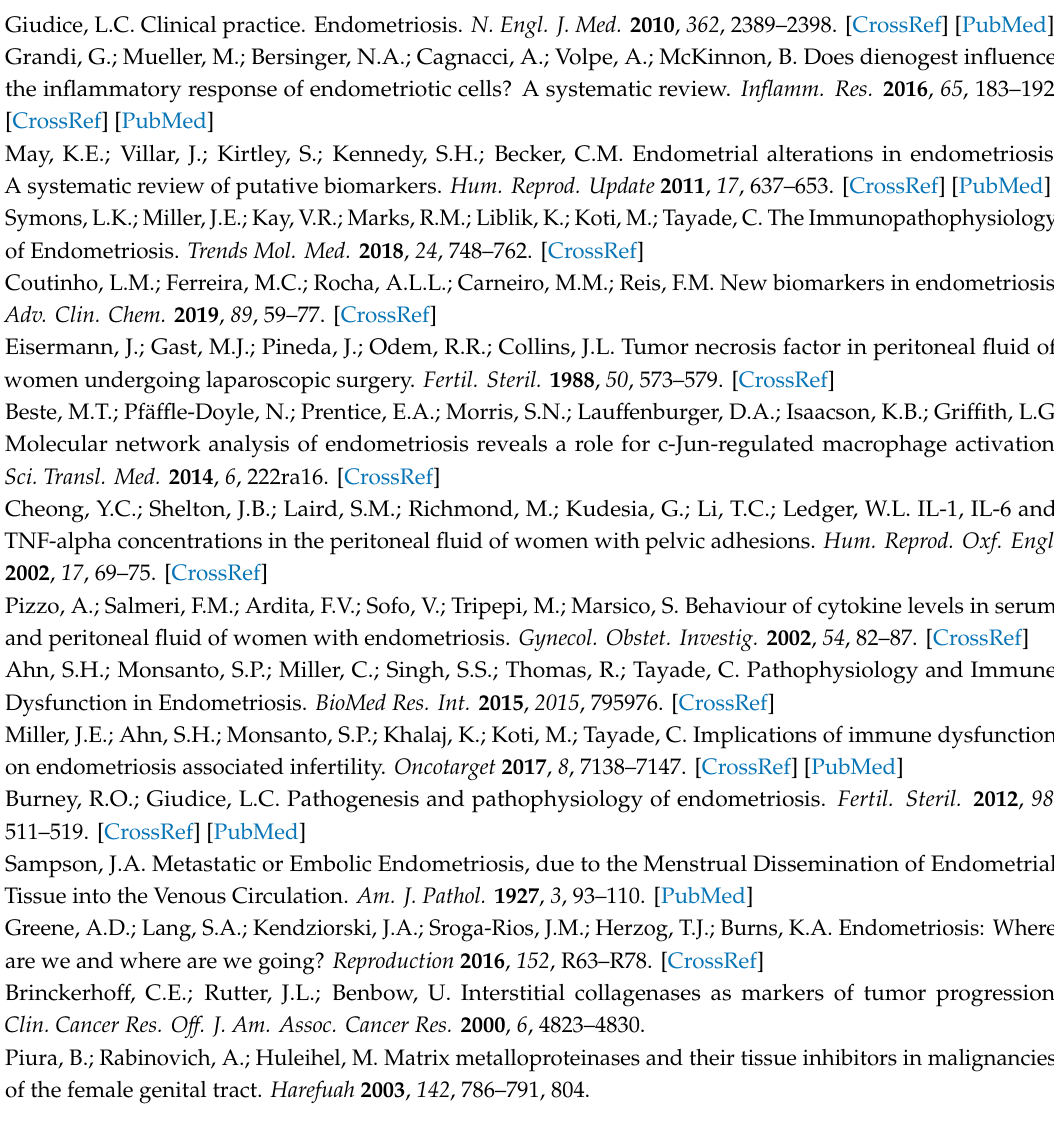
Supplementary Table S1: HeatMap for relative protein abundance of MMPs and TIMPs in glandular and stromal compartments, measured by immunofluorescence; Supplementary Table S2: List of antibodies used in this